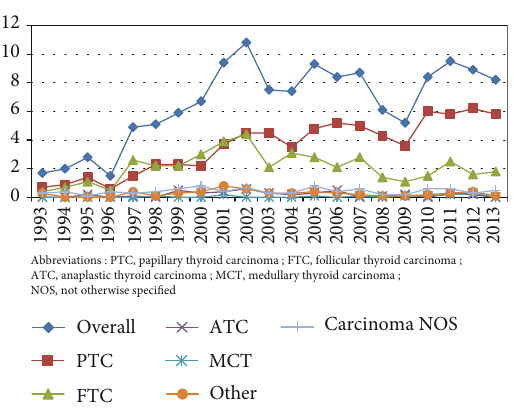
Figure 2: Age-standardized (world population) thyroid cancer incidence, overall and for the major histologic